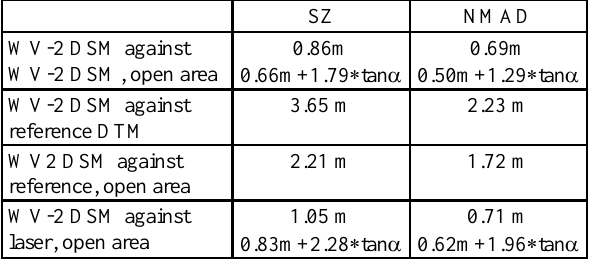
Table 4: accuracy analysis of WorldView-2 DSM Istanbul